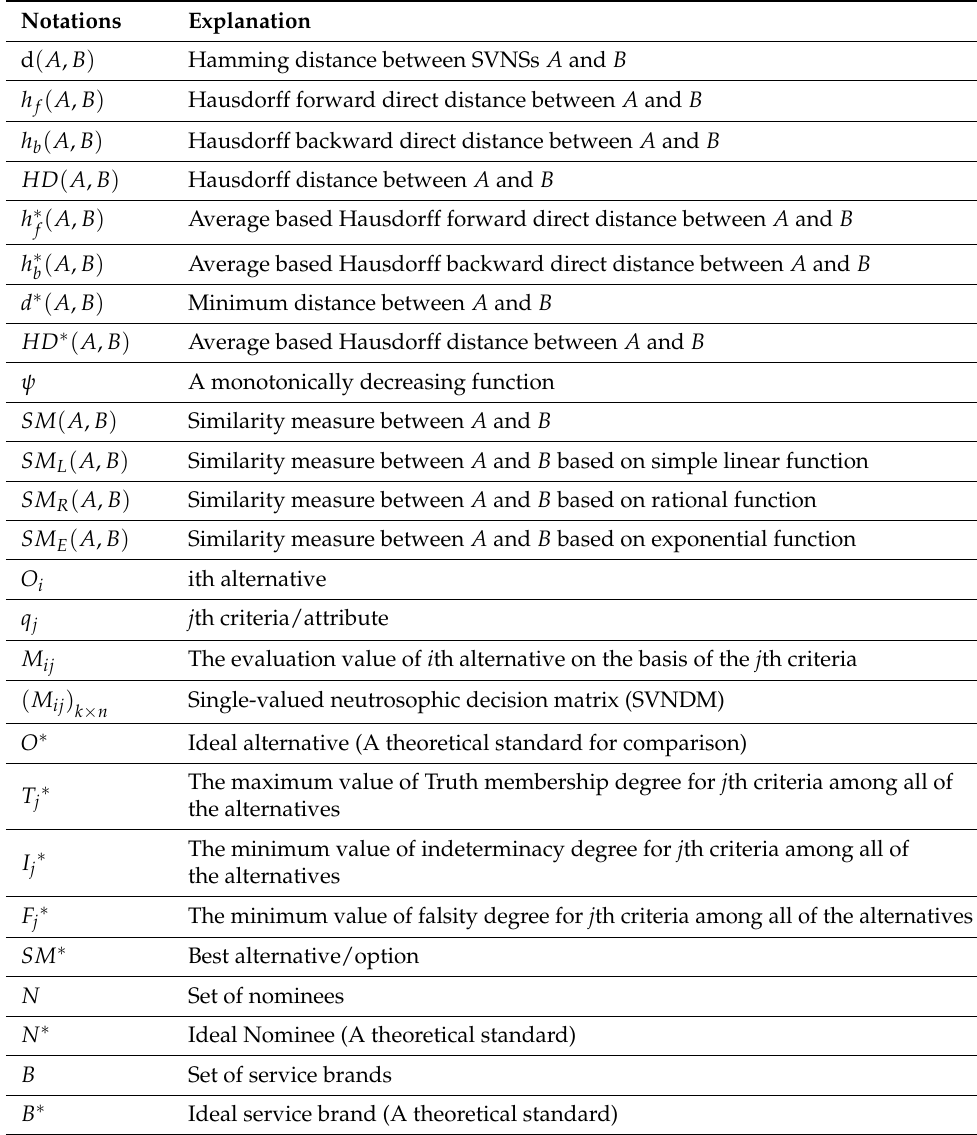
Table 2. Notations and